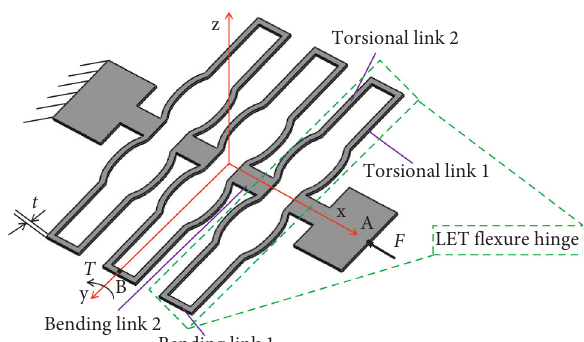
Figure 1: 3D model of the TLET